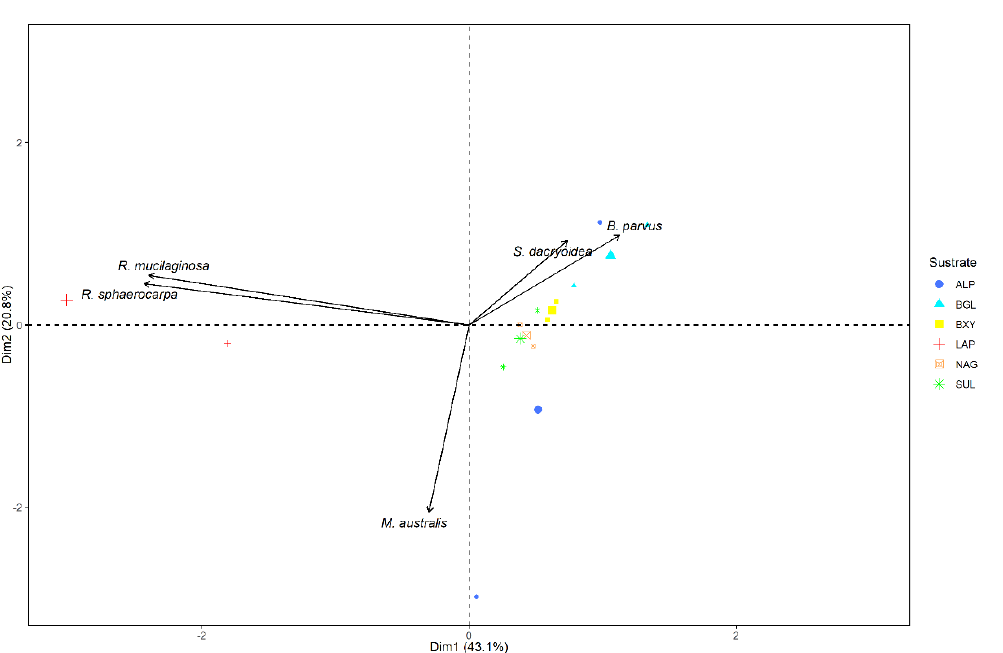
Figure 6. PCA plot from the normalization of the total enzymatic activity (V max ) with the biomass (dry weight) at 5 °C and 20 °C for all the species. This was compared for each substrate, which corresponds to alkaline phosphatase (ALP), β -glucosidase (BGL), β -xylosidase (BXY), leucine aminopeptidase (LAP), N -acetyl- β -D-glucosaminidase (NAG), and sulfatase (SUL).